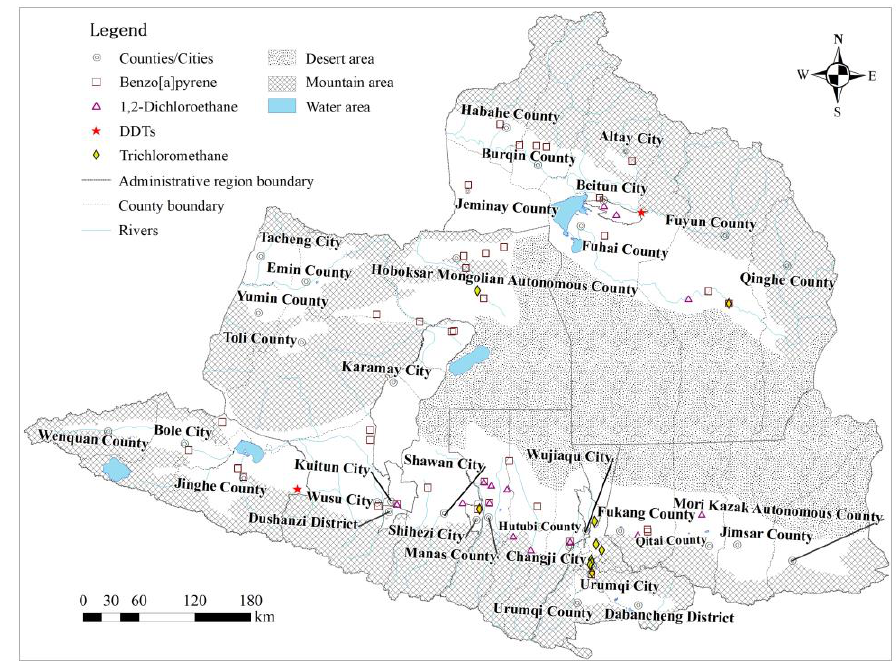
Figure 6. Distribution of PCOP in groundwater.